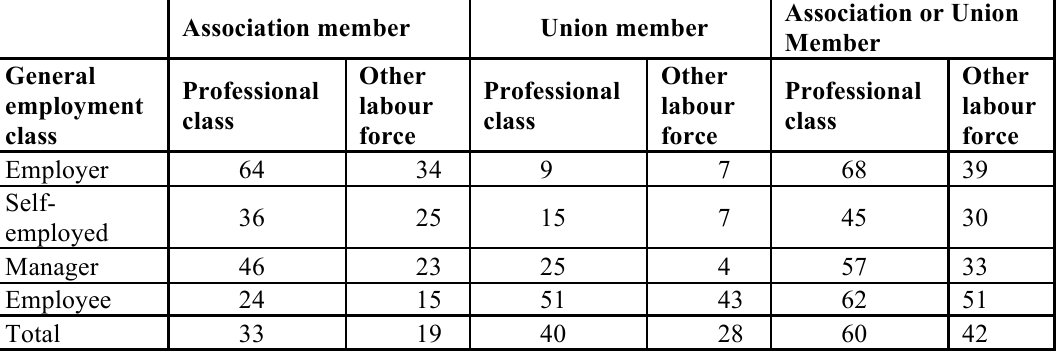
General employment class and professional class by association and union membership, 2004 (%) Association